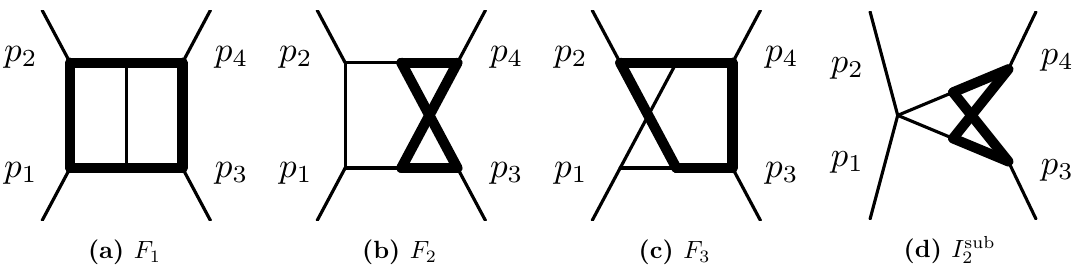
are shown here. p 1 ; p 2 are 2